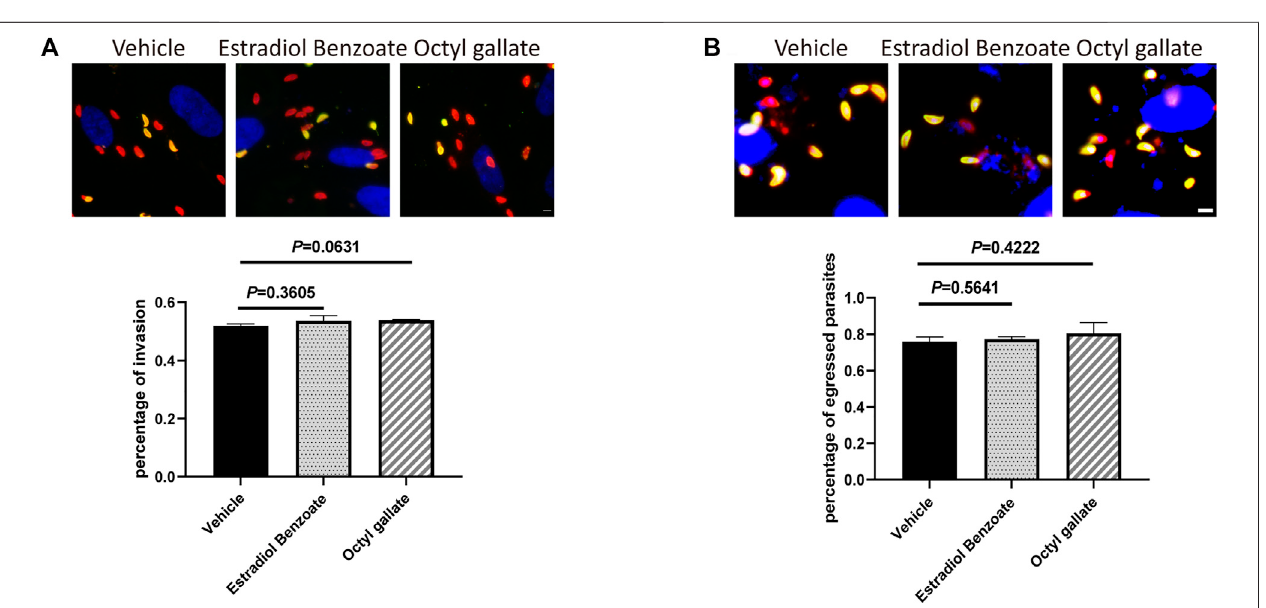
Frontiers in Pharmacology |